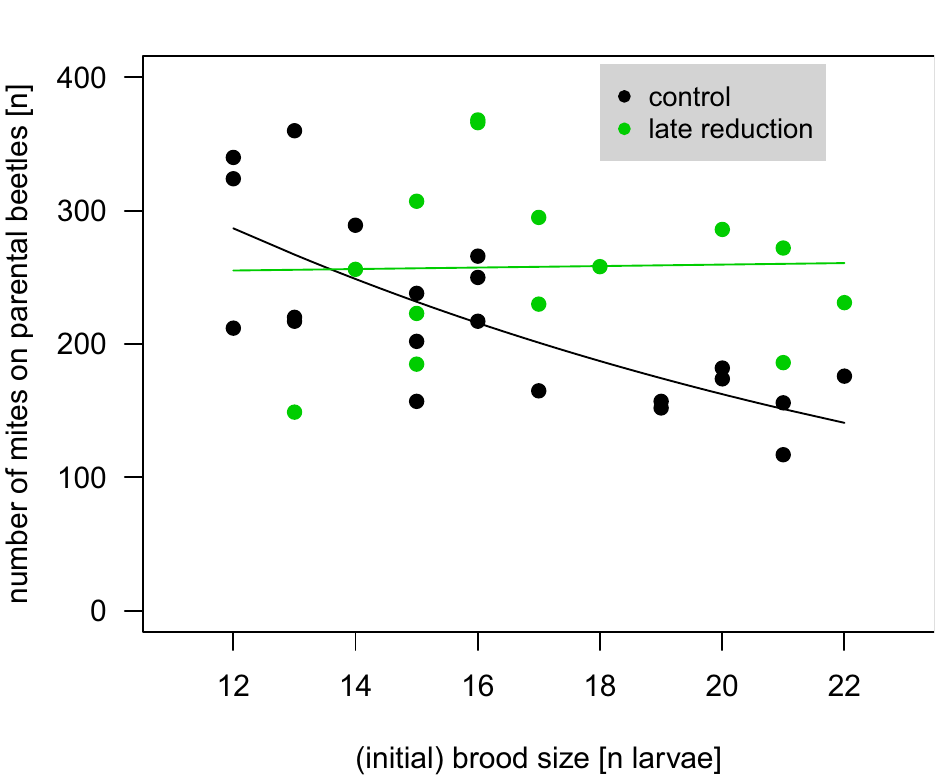
Fig 5. Initial beetle brood size and mites that left the carcass with the parental beetles. The number of mites that developed on carcasses depended on the number of beetle larvae in control replicates of normal size (control treatment, p < 0.001). The effect was weaker when brood size was reduced three days after the larvae hatched (late reduction treatment, n = 15, interaction treatment x brood size p < 0.05). Points depict individual replicates, lines are regression